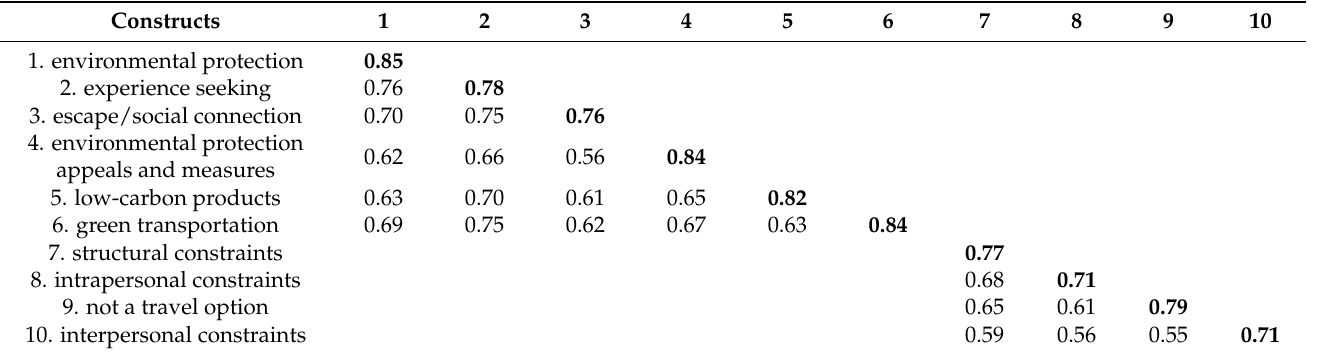
Table 7. Discriminatory validity of Low-Carbon Motivation and Constraint Scale.